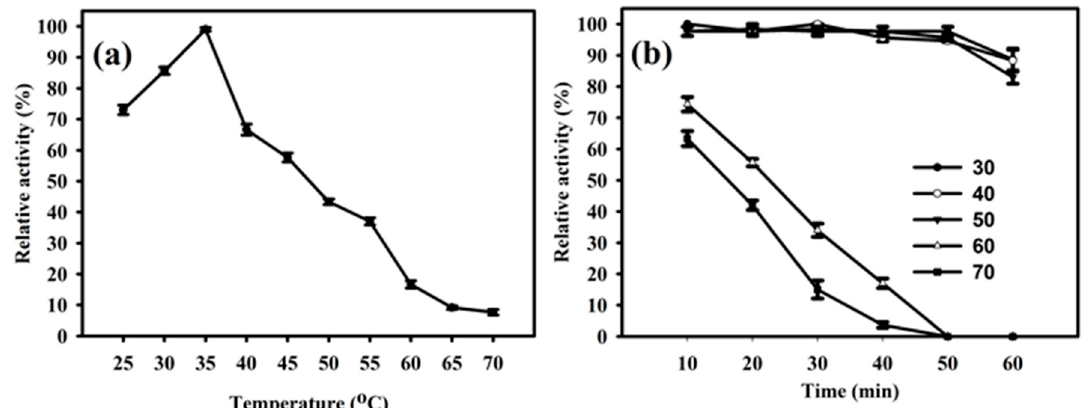
Figure 4. Effect of temperature on the activity and stability of PhyRC001. ( a ) Optimal temperature for PhyRC001 is 35 °C, as determined by measuring its enzymatic activity with 1% ( w / v ) Na-IHP in 50 mM sodium acetate buffer, pH 7, at 25 to 70 °C in five degree increments; and ( b ) thermostability was determined by measuring the enzymatic activity of PhyRC001 after incubation at 30 to 70 °C in 10 degree increments for 60 min.